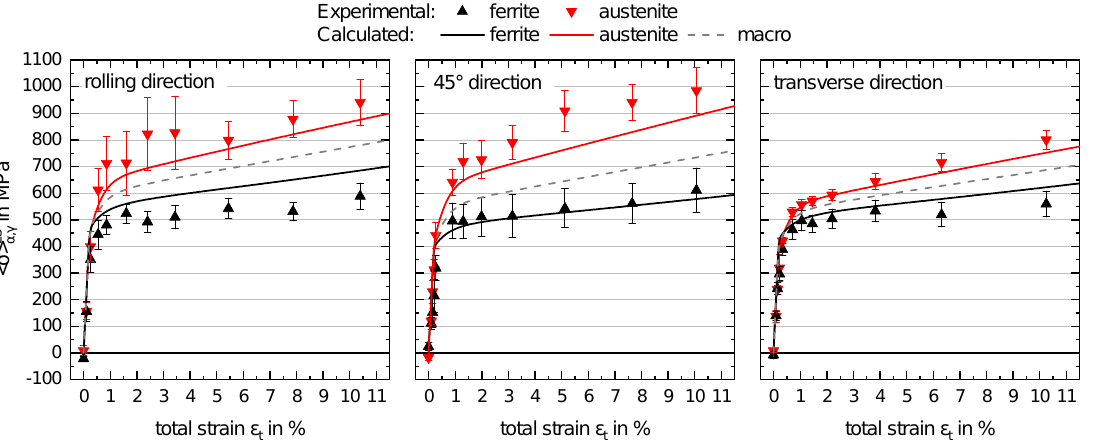
Figure 11. Comparison of calculated (lines) and experimental (symbols) results: Fitted strain hardening of transverse direction ( right ) and simulated strain hardening for uniaxial loading in rolling direction ( left ) and 45 ◦ direction ( center